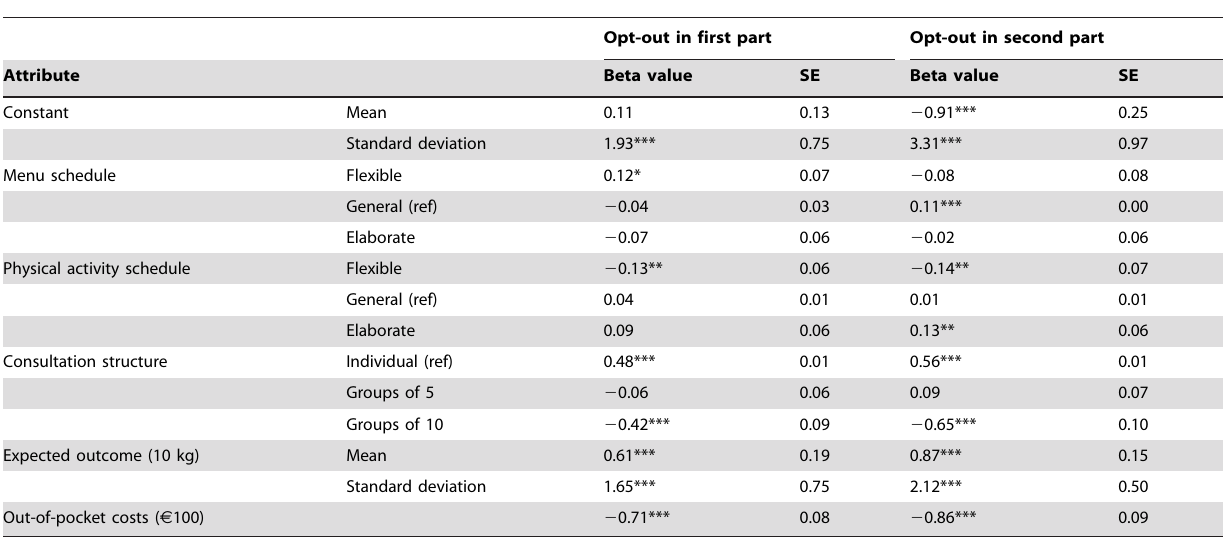
Table 4. Attribute estimates (standard errors) of the MIXL stratified by location of the